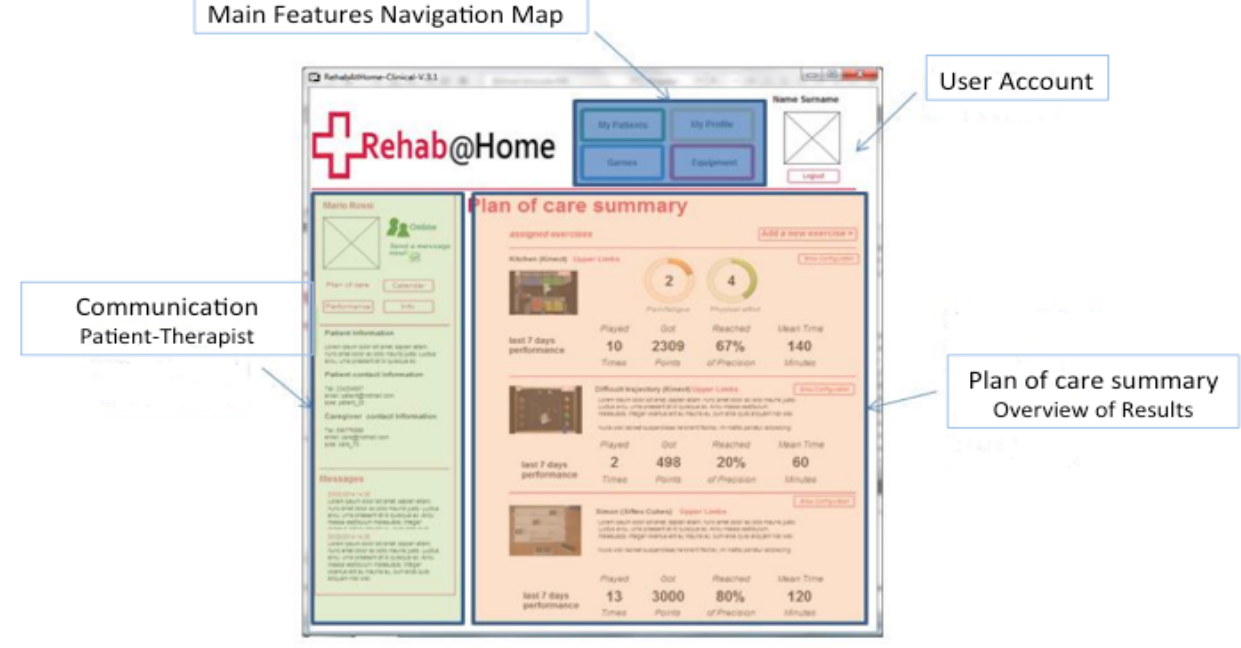
Figure 2: Overview of the Professional Station main